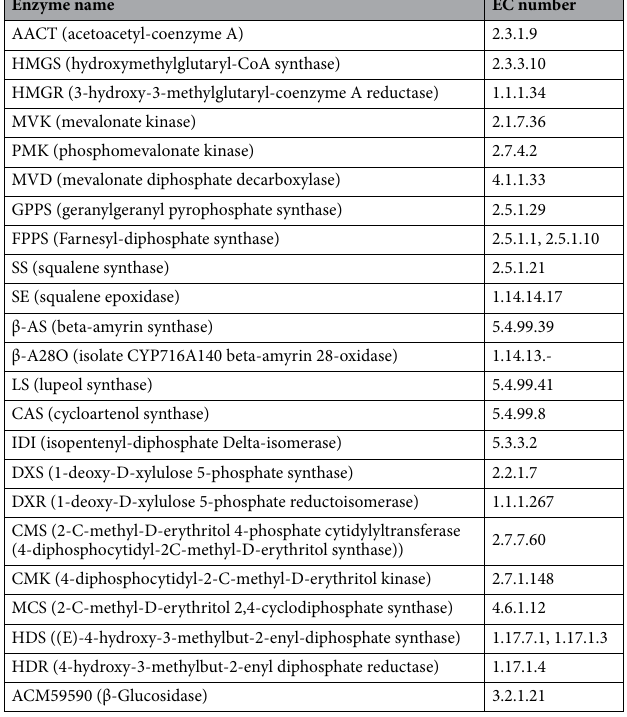
Table 2. Putative key enzymes involved in the triterpenoid saponins biosynthesis pathway in P. grandiflorus